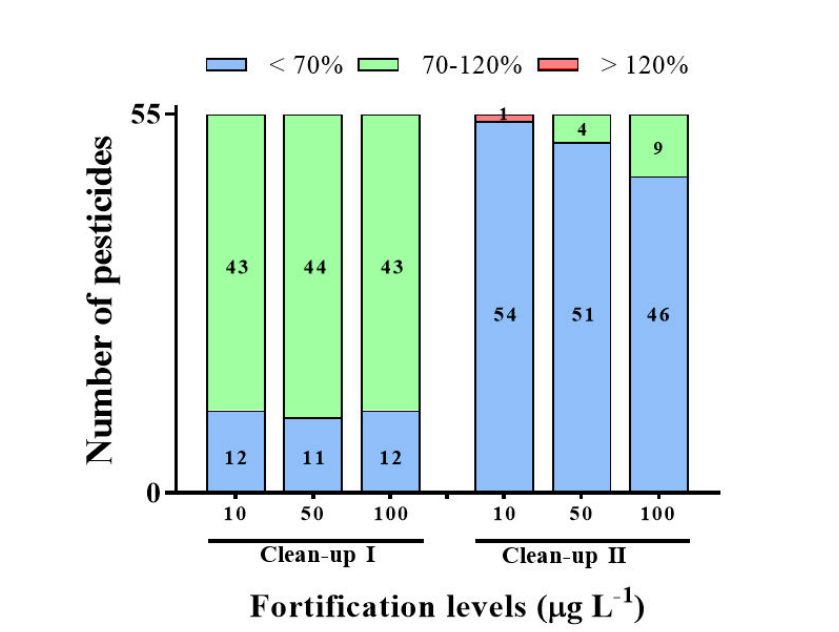
Figure 2. The recoveries of di ff erent clean-up procedures for LC-MS / MS at the spiked level of 10, 50, and 100 µ g L − 1 . The di ff erent clean-up procedures used were as follows: Clean-up I (50 mg C 18 , 50 mg PSA, and 150 mg MgSO 4 ); Clean-up II (50 mg C 18 , 50 mg PSA, 50 mg GCB, and 150 mg MgSO 4